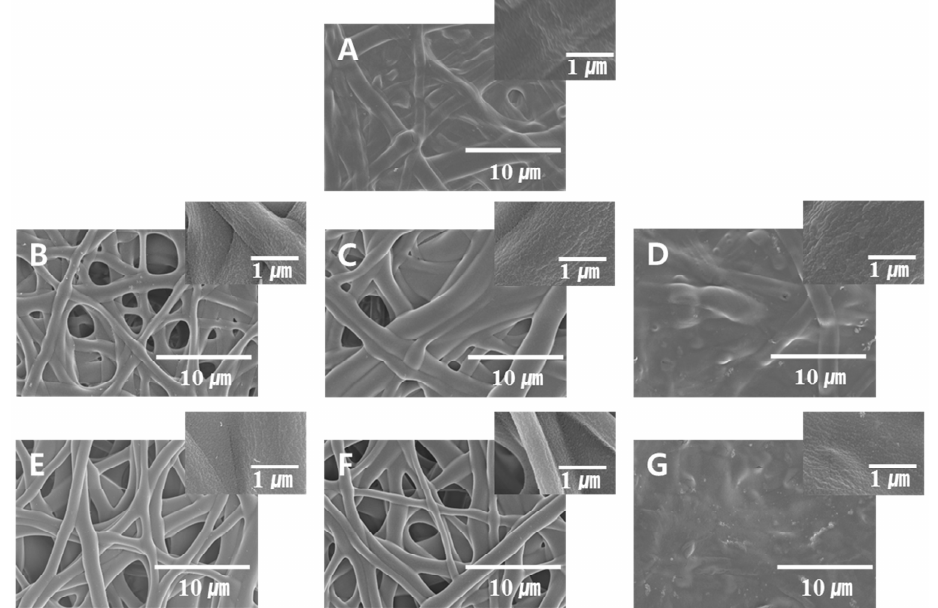
Figure 4. FE-SEM images of saponified PVA nanofiber mats obtained using saponification solution prepared using different respective quantities of NaOH, Na 2 SO 4 , and MeOH per 100 g of H 2 O: ( A ) 5, 5, and 5 g; ( B ) 7.5, 5, and 5 g; ( C ) 5, 7.5, and 5 g; ( D ) 5, 5, and 7.5 g; ( E ) 10, 5, and 5 g; ( F ) 5, 10, and 5 g; and ( G ) 5, 5, and 10 g. The saponification temperature and time were kept constant at 25 ◦ C and 24 h,